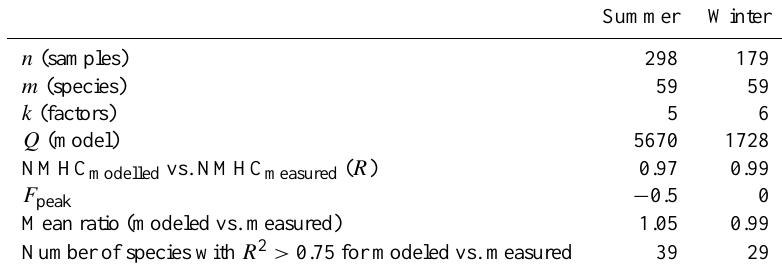
Table 1. Mathematical diagnostic for the PMF results.